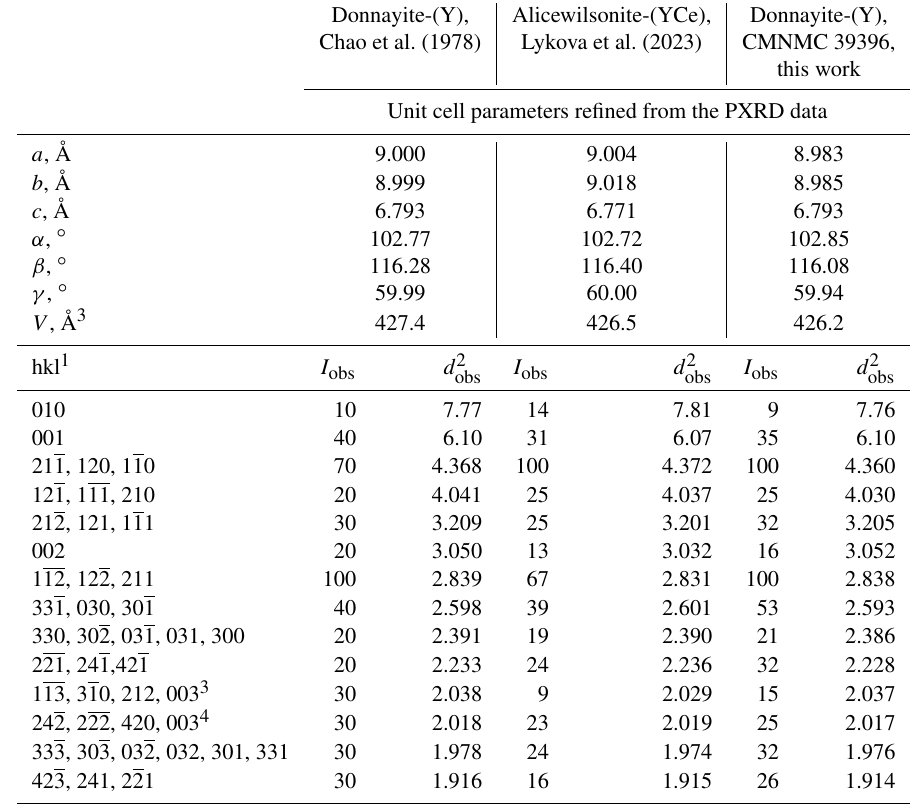
Table 4. Comparative powder X-ray diffraction data for donnayite-(Y) (original and current study) and alicewilsonite-(YCe). Donnayite-(Y), Alicewilsonite-(YCe), Donnayite-(Y),